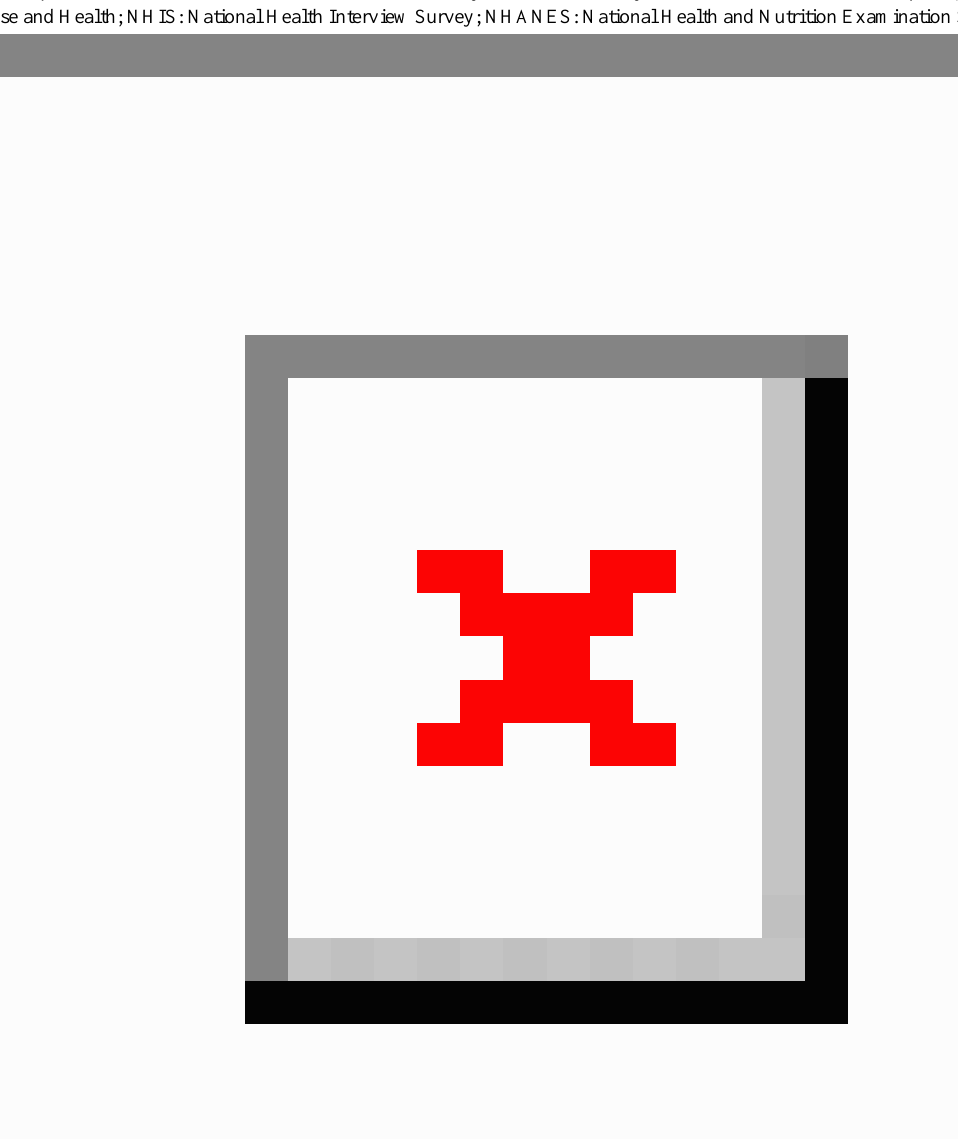
Figure 5. Comparison of estimates available across national surveys. NMURx: Survey of Non-Medical Use of Prescription; NSDUH: National